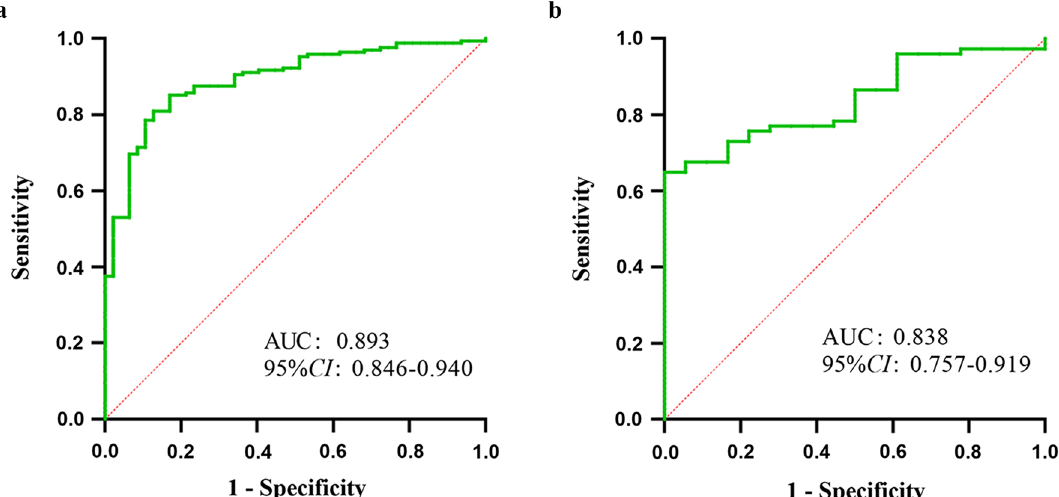
Fig. 4 The ROC curves for predicting the occurrence of ACLF within 90 days. The AUC value of model was 0.893 (95% CI 0.846–0.940) in the training group ( a ) and 0.838 (95% CI 0.757–0.919) in the validation group ( b ). ROC, receiver operating characteristic; ACLF, acute-on-chronic liver failure; AUC,